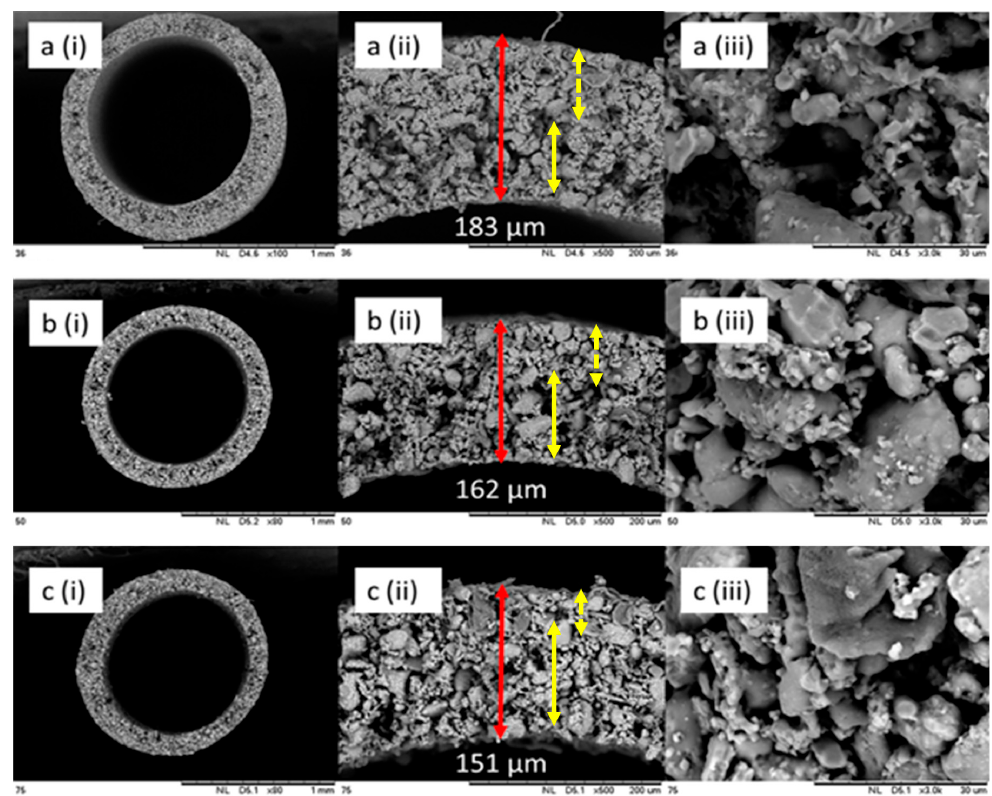
Figure 3. Scanning electron microscopy (SEM) micrographs of the HFCMs at different magnifications ( i ) × 60, ( ii ) × 500 and ( iii ) × 3000 of ( a ) 36 µ m, ( b ) 50 µ m, and ( c ) 75 µ m, spun at 45 wt % ceramic loading, 5 cm of air-gap distance and 15 mL/min of bore fluid flowrate. (Note: full yellow arrow noted the finger-like or macro void region while dotted arrow showed the sponge-like structure).